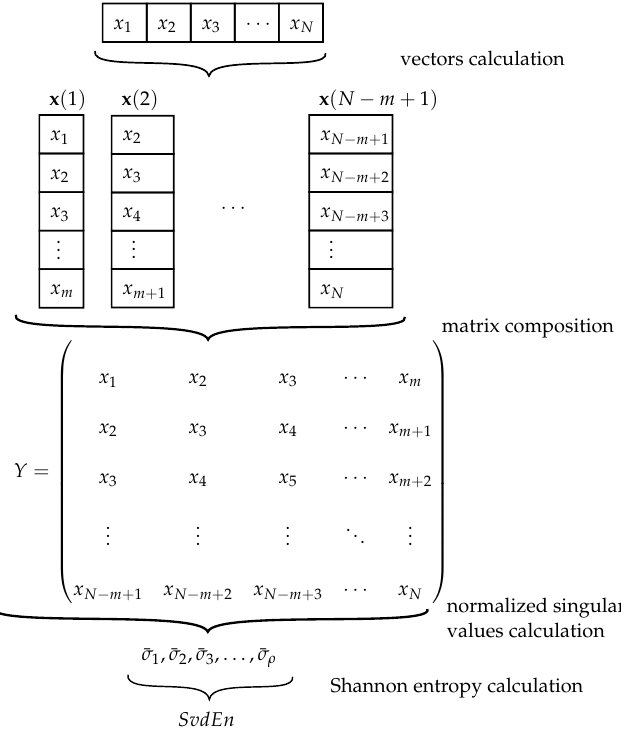
Figure 5. Diagram of the singular value decomposition entropy (SvdEn)